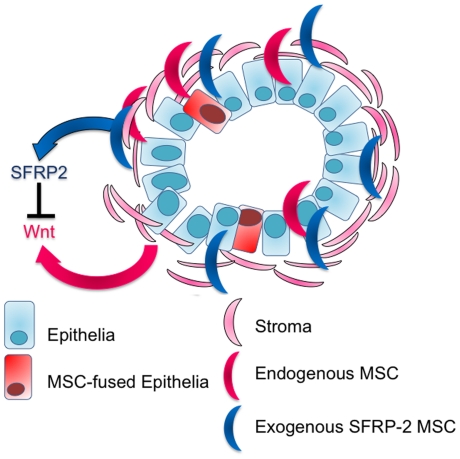
MSCs contribute to CRPC.This diagram represents a transformed prostate gland. Rounded turquoise rectangles indicate epithelial cells with an irregular nuclear shape and the larger pink half moon shapes represent the stromal compartment. The stroma surrounds the ducts, and is invaded by the transformed epithelia. The recruited endogenous-MSCs (red) contribute to Wnt signaling in CRPC. Whereas, the recruited therapeutic-MSCs that express SFRP-2 (blue) antagonize Wnt signaling in CRPC. Rounded red rectangles indicate epithelial cells that have fused with recruited MSCs.